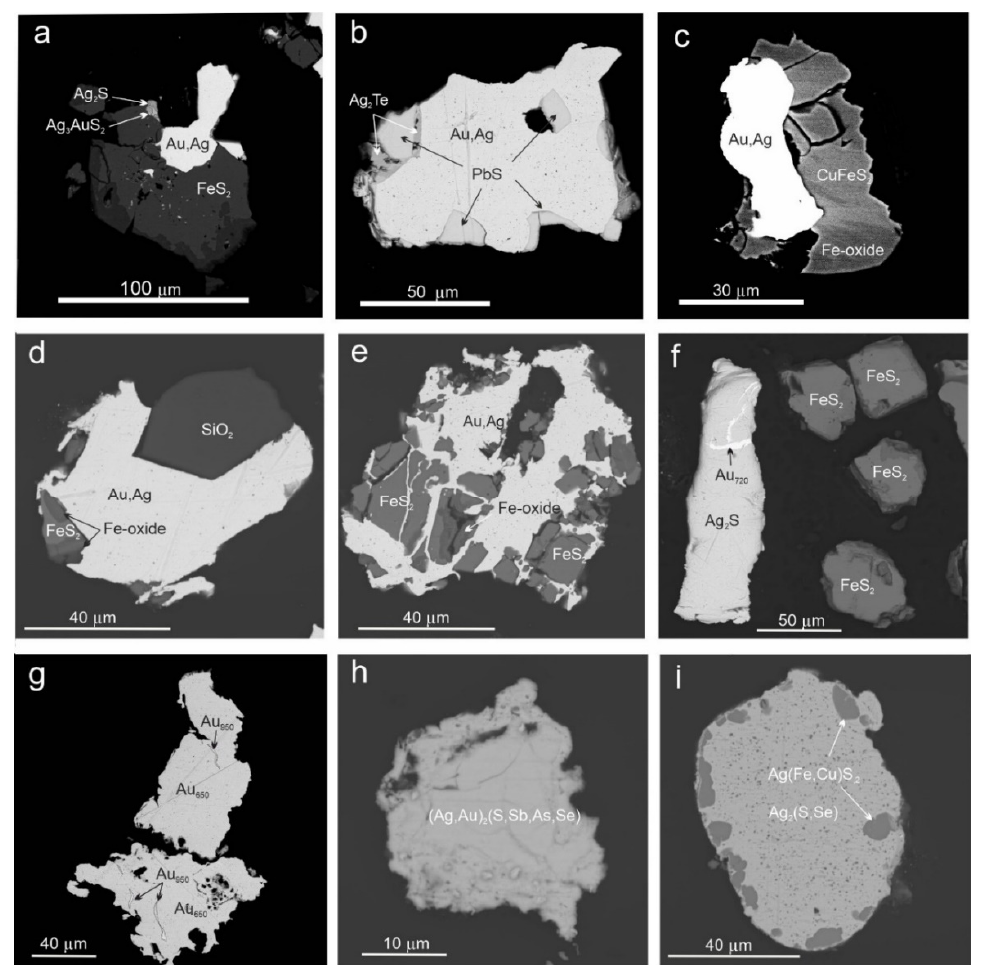
Figure 8. Microparagenesis of the gold-pyrite-quartz association: ( a )—low-grade gold intergrown with pyrite FeS 2 in assemblage with akantite Ag 2 S and uytenbogardite Ag 3 AuS 2 , Rusty zone; ( b )—low-grade gold in intergrowth with galena PbS, hessite Ag 2 Te and petzite Ag 3 AuTe 2 , Rusty zone; ( c – e )—low-grade gold in intergrowth with chalcopyrite and pyrite replaced by Fe-oxide, Central zone; ( f )—hessite with vein-like inclusions of low-grade gold; ( g )—low-grade gold with vein-like inclusions of high-grade gold, South Zone; ( h – i )—grains of Sb,As,Te-bearing akantite (Ag,Sb,As,Se) 2 S sometimes replaced by lenaite Ag(Fe,Cu)S 2 , the poorly compacted argillaceous-ocher rocks underneath the ore bodies, Southern zone.